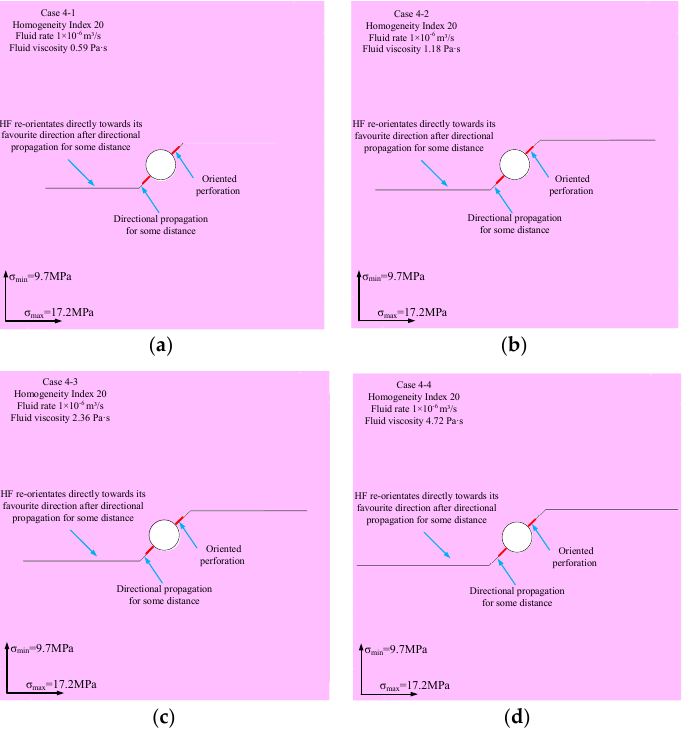
Figure 10. The relationship between HF re-orientation and fluid viscosity when the homogeneity index is equal to 20: ( a ) fluid viscosity is 0.59 Pa·s; ( b ) fluid viscosity is 1.18 Pa·s; ( c ) fluid viscosity is 2.36 Pa·s; ( d ) fluid viscosity is 4.72 Pa·s. The findings reveal that the influence laws and principles of fluid viscosity on HF re- orientation are similar to those of fluid rate in both heterogeneous and relatively homo- geneous rocks. The increase in flow rate or fluid viscosity gradually diminishes the lateral fluid leak-off, which significantly increases the volume of fluid flowing along the perfo- ration direction, thereby enhancing the guidance of perforation on HF propagation and improving the fracturing performance. Besides, the HF propagation trajectory does not change when the fluid viscosity and fluid rate are changed within a reasonable range un- der the same homogeneity index and the constant product of fluid viscosity and fluid rate. (See Figures 7b and 9a; Figures 7c and 9b; Figures 8b and 10a; Figures 8c and 10b). 3.4. Effect of Perforation Angle In this section, hydraulic fracturing at the perforation angles of 15°, 30°, 45°, 60° and 75° is simulated when the homogeneity indexes are 2 and 20, respectively. According to the simulation results in Sections 3.2 and 3.3, the injection parameters here are 1 × 10 − 6 m³/s and 1.18 Pa·s. Table 8 provides the details of scenarios 5 and 6. Figures 11 and 12 are the simulated results of these scenarios, respectively. Figure 11 illustrates that the re-orienta- tion distance gradually increases by increasing the perforation angle in heterogeneous rocks (m = 2). It is worth noting that the perforation angle of 45° appears to be a critical angle. When perforation angles are less than 45°, the HF re-orientation distances are very short and HFs initiating from perforations rapidly re-orientate towards their favorite di- rections (Figure 11a,b), whereas HFs undergo obvious re-orientation processes and the re- orientation distance increases rapidly with the increase of perforation angle when perfo- ration angles are greater than 45° (Figure 11c–e). Figure 12 lists the HF propagation trajec- tories of different perforation angles in relatively homogeneous rocks (m = 20). Obviously, the change of perforation angle has little influence on the HF re-orientation process in relatively homogeneous rocks. Although HFs undergo certain directional propagation distances, the distances are nearly equal. Therefore, this is more likely to be the cause of high fluid viscosity and fluid rate. Figures 11 and 12 suggest that the use of large perforation angles is efficient in guid- ing HF propagation within certain distances if the rock is relatively heterogeneous. How- ever, the control of perforations over HF propagation might be limited in relatively ho- mogeneous rocks. He et al. [5] believes that borehole arrangements under these circum- stances should consider the direction of in-situ stress. The borehole axis should be aligned with the minimum in-situ stress direction if a series of radial HFs are required or perpen- dicular to the minimum in-situ stress direction if a series of axial HFs are expected. Other